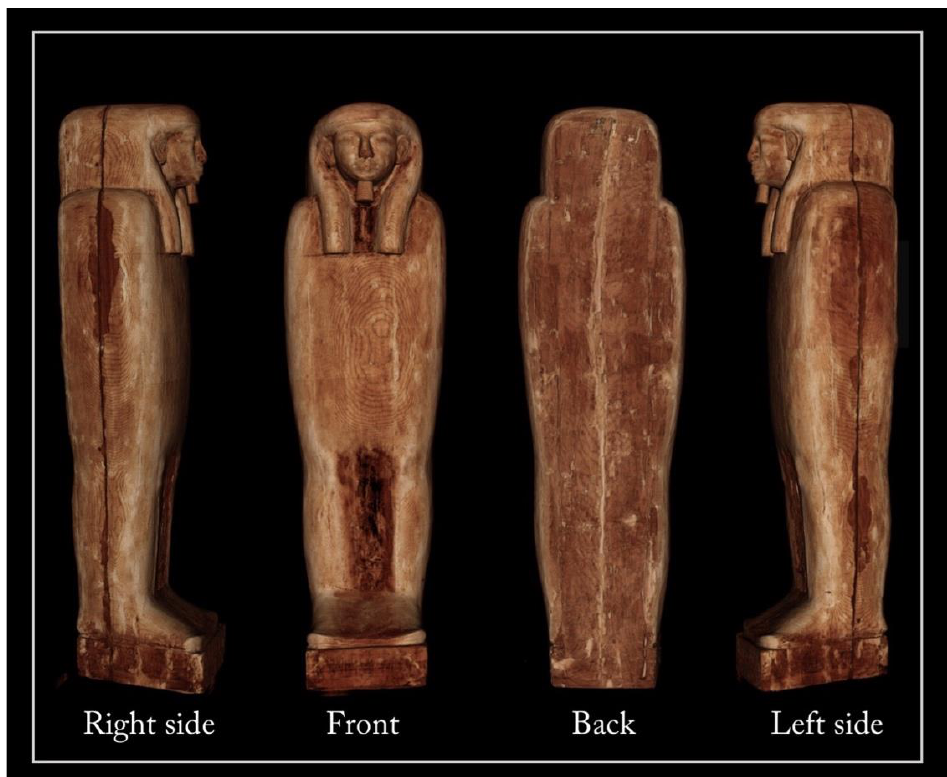
Figure 15. The stucco on the outer surface of the coffin.